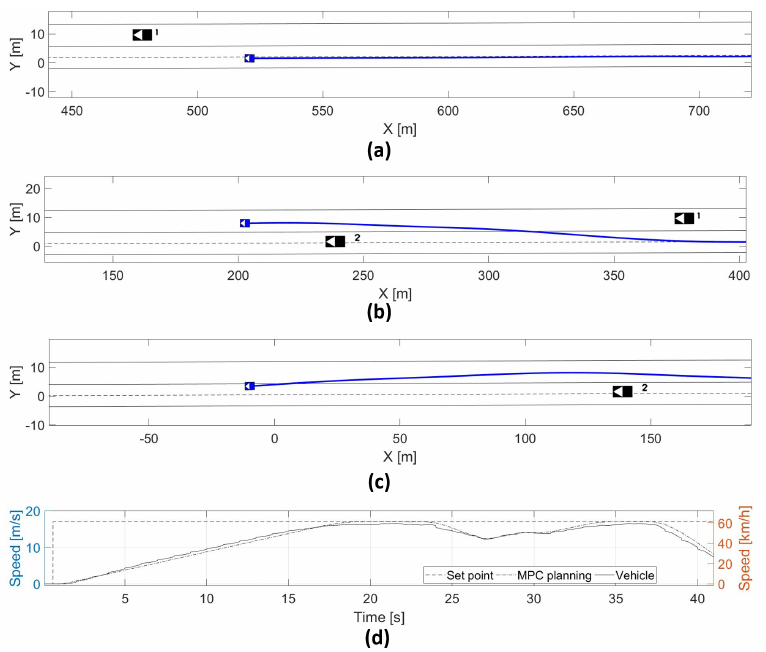
Figure 10. ( a ) High speed test track until 22 s, ( b ) high speed test track until 30 s, ( c ) high speed test track until 34 s, ( d ) vehicle test track in the overtaking